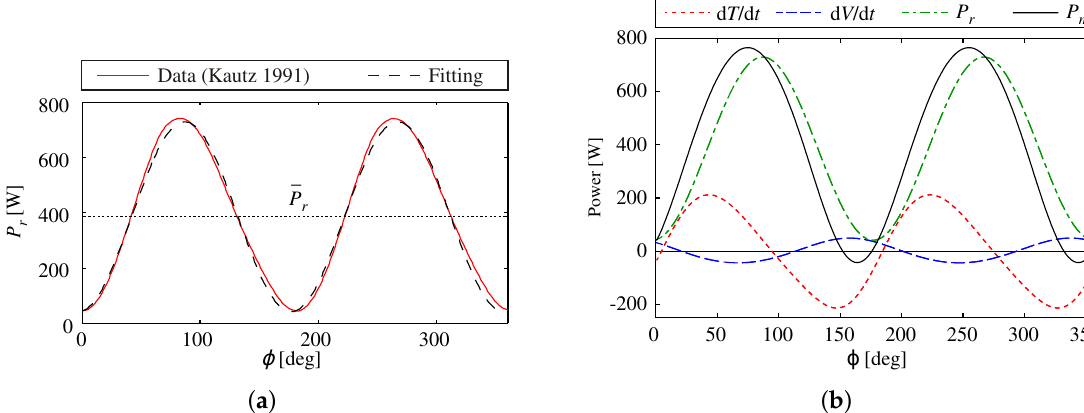
Figure 3. ( a ) resistant power P r vs. crank angle ϕ ; data from [36] and fitting obtained by Equation (15); ˙ ϕ = 90rpm, ¯ P r = 385W; ( b ) components and total power output P m vs. crank angle ϕ ; ˙ ϕ = 90rpm, ¯ P r = 385W, m = 70kg, h = 1.75m.